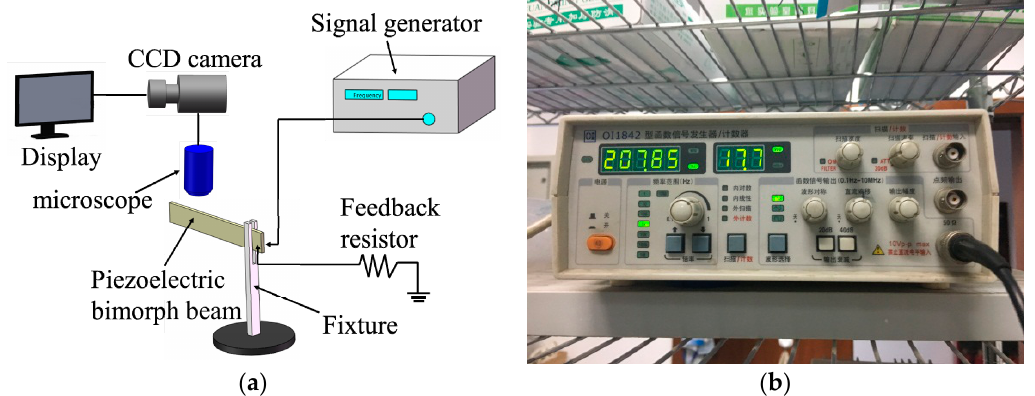
Figure 5. ( a ) Schematic diagram of the microscope image observation method and ( b ) the value of the signal generator when the piezoelectric bimorph beam is in a resonant state.